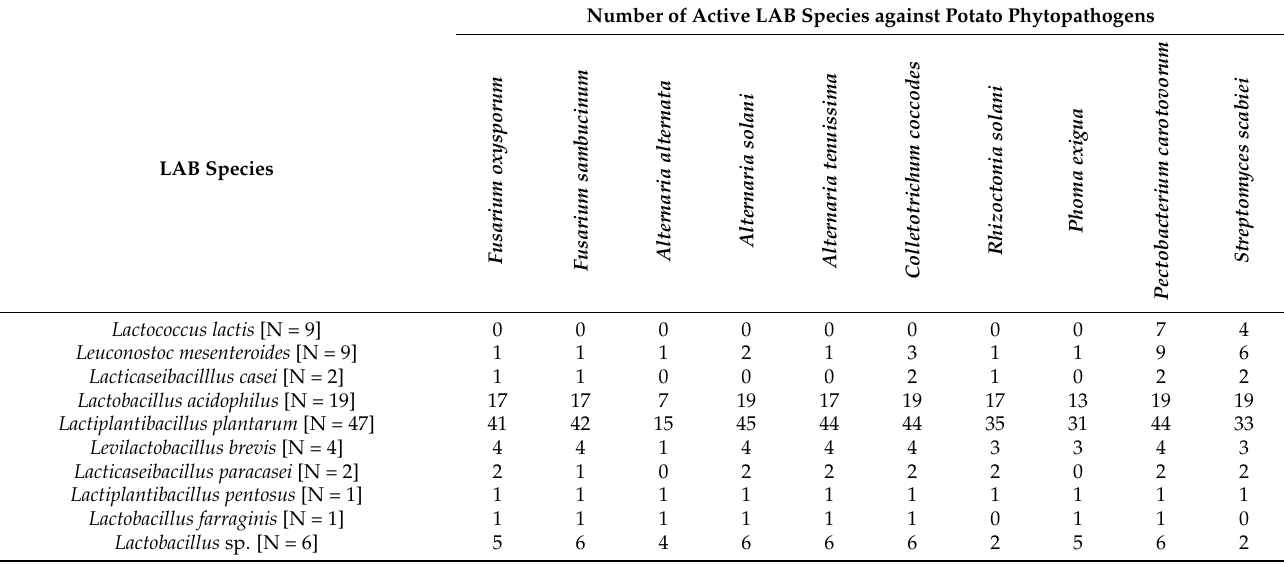
Table 2. The antimicrobial activity of different species of lactic acid bacteria (LAB) cultivated on MRS medium against potato